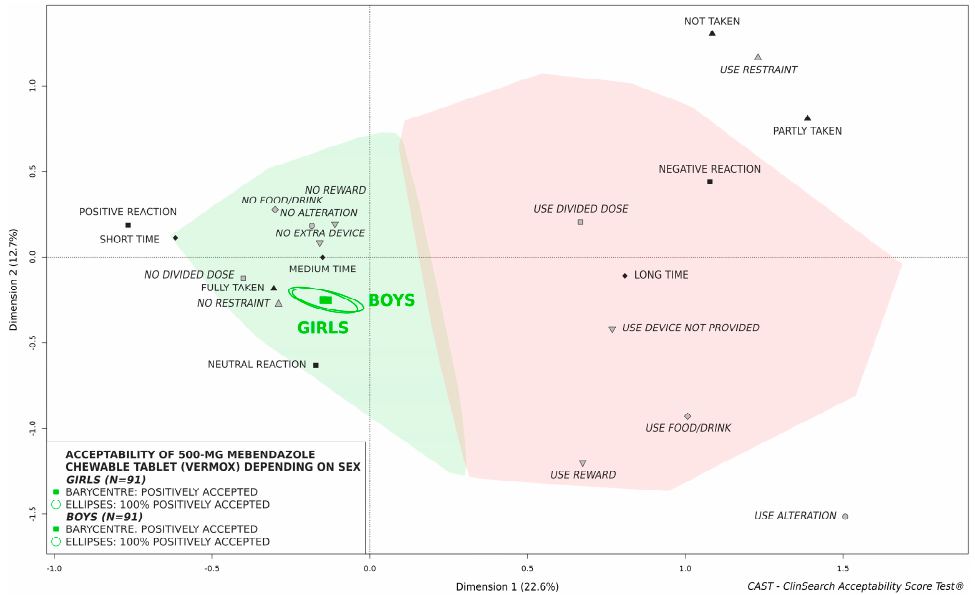
Figure 5. Influence of sex on acceptability of 500-mg mebendazole chewable tablet in children aged 2 to 4 years.